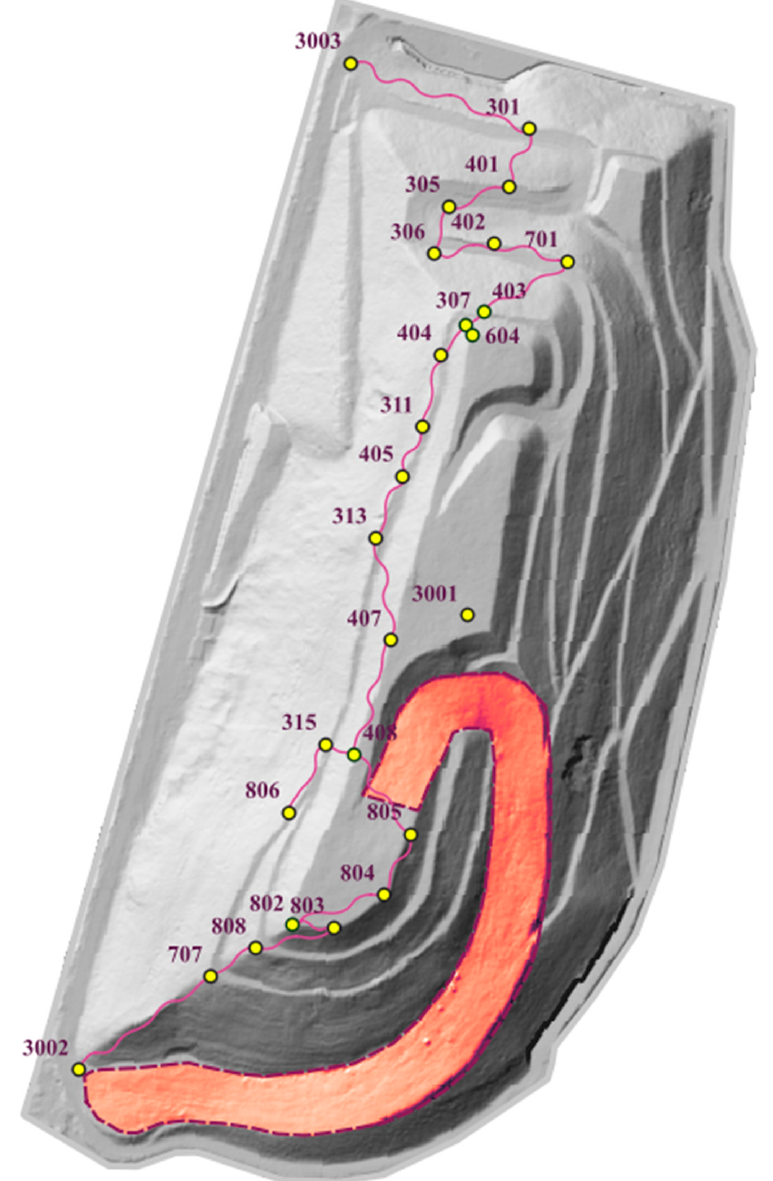
Figure 5. Location of the analyzed homologous points and the ski run. Approach 2: TLS measurement was limited to the ski run located in the southeastern part of the landfill. The range of measurements is marked in red in Figure 5 (bounded by a purple dashed line). Only cloud-to-cloud distance analyses obtained from methods 1–3 were performed in this